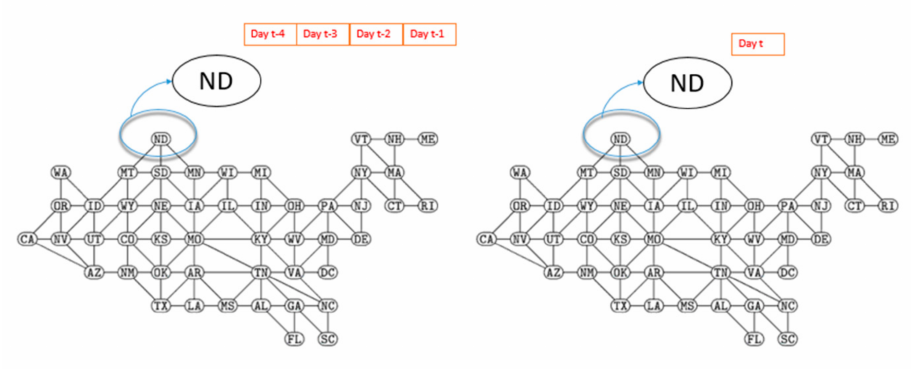
Figure 5. Training dataset. The node features of the state of North Dakota (ND) are